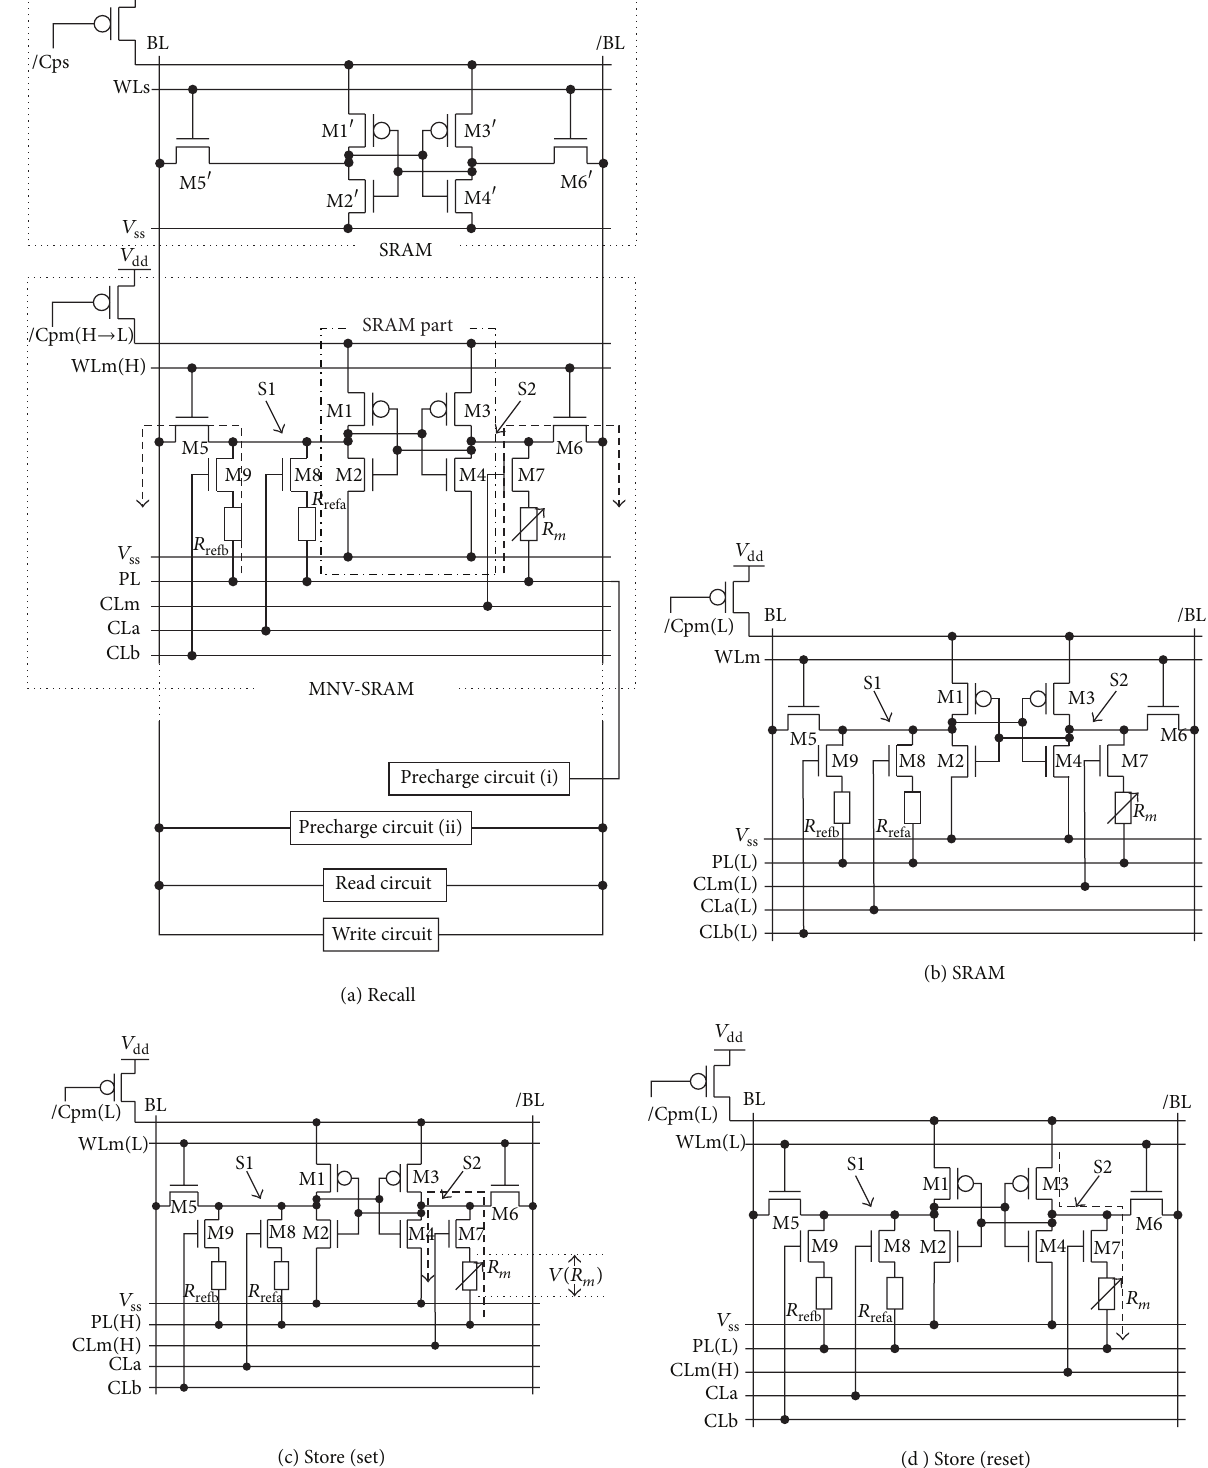
Figure 5: Operation scheme for